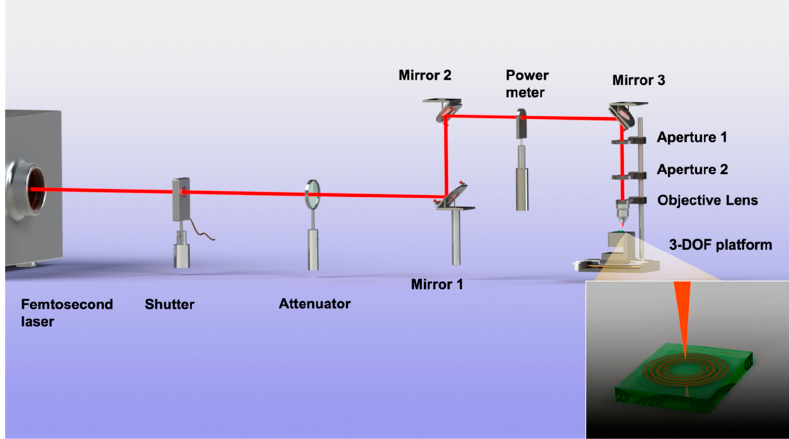
Figure 3. Schematic diagram of femtosecond laser processing system.